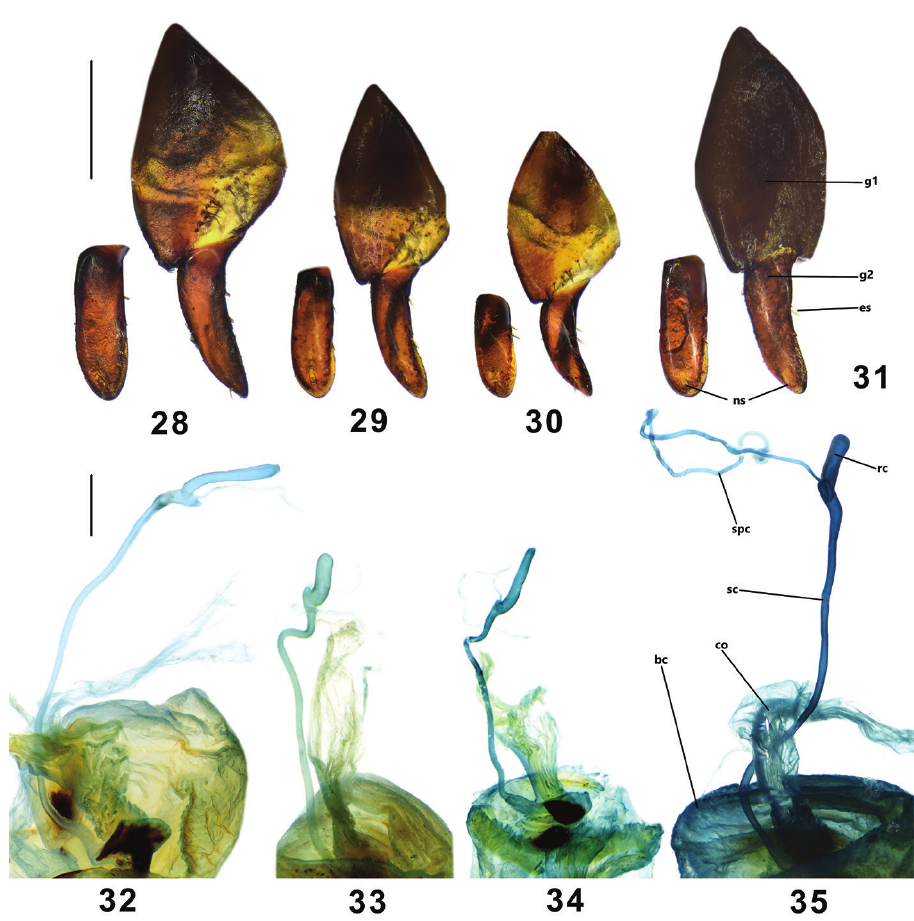
Figures 28–35. Female genitalia of Pterostichus ( Koreonialoe ) spp. from China, Figs 28–31 ventral view and inner lateral view of ovipositor. Figs 32–35 female reproductive system. 28, 32 P. tetralobatus , Para- type from Laopingding, Liaoning 29, 33 P. syleus , a female from Baishilazi, Liaoning 30, 34 P. micropo- ides , female, Paratype from Antu county, Jilin 31, 35 P. bellatrix , a female from Fusong county, Jilin.